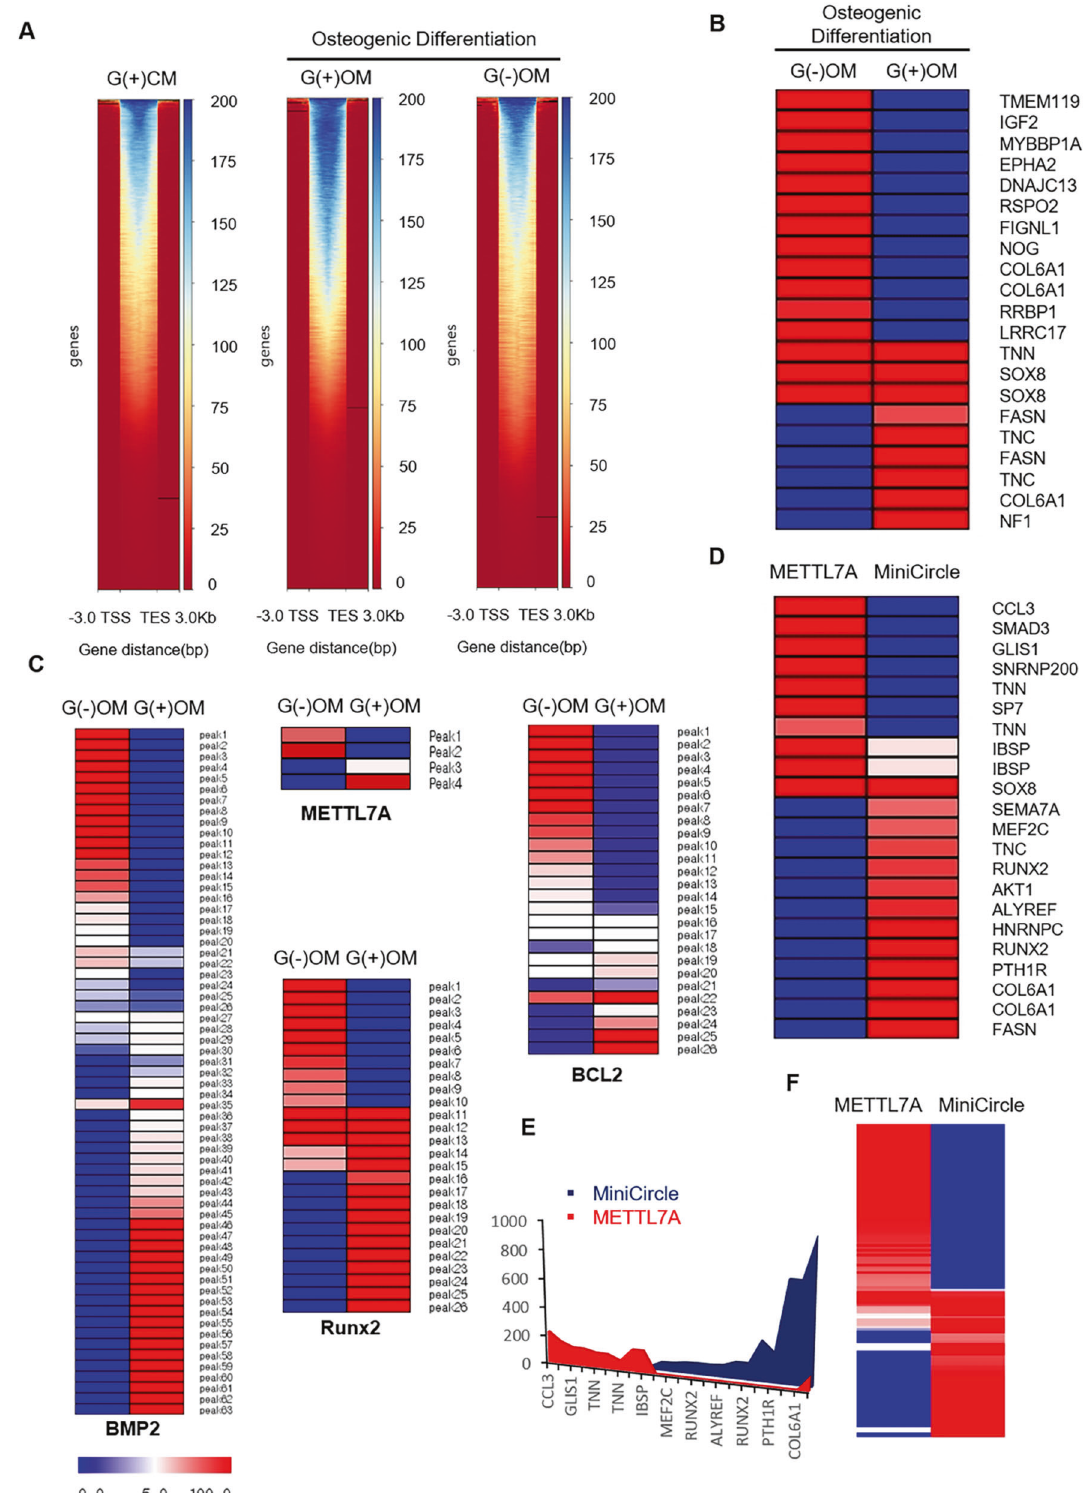
related to anti-apoptosis. The methylation peaks of those genes varied strongly between the two conditions (Fig. 6C). Gene peak heatmap and graph using MeV 4.9.0 was generated to visualize the relative differences in promotor methylation between METTL7A-transfected hBMSCs and control